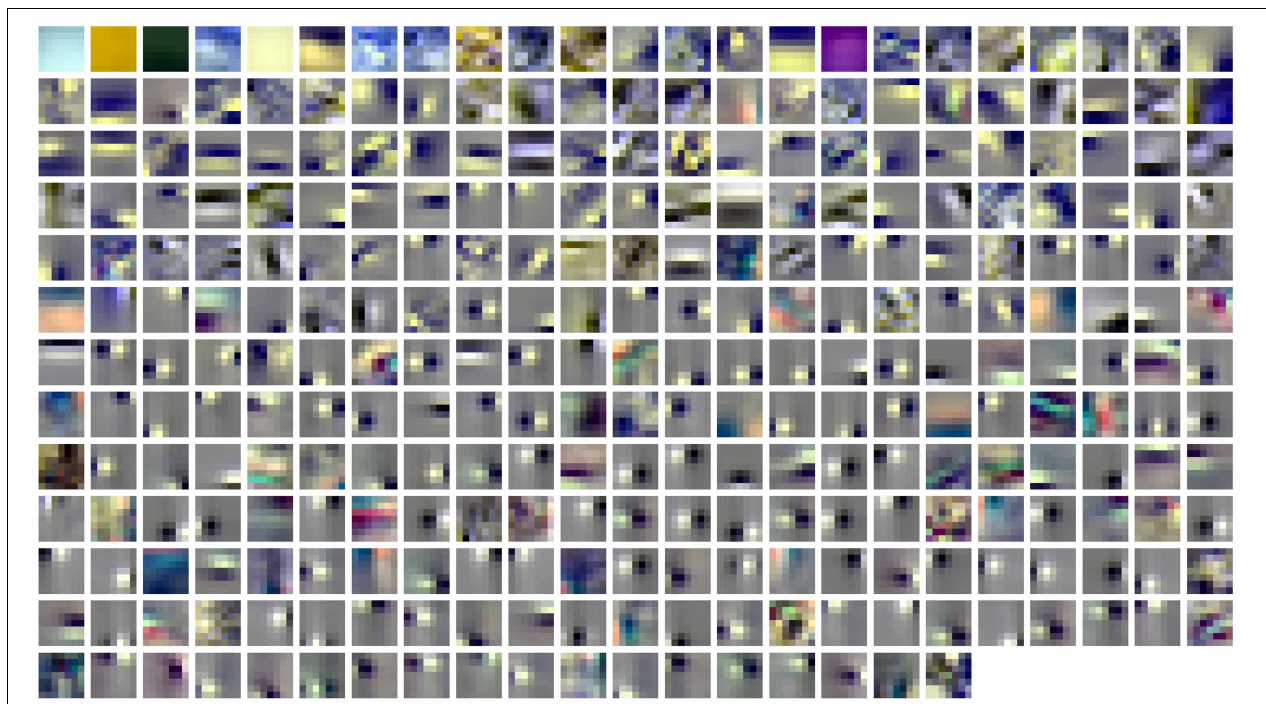
FIGURE 3 | Spatio-chromatic structure of the activation triggered averages for all 294 learned ICA basis functions. R, G, and B pixel values for each 7x7 patch correspond to L, M, and S cone excitations that were derived from individual basis functions using a reverse correlation based approach.